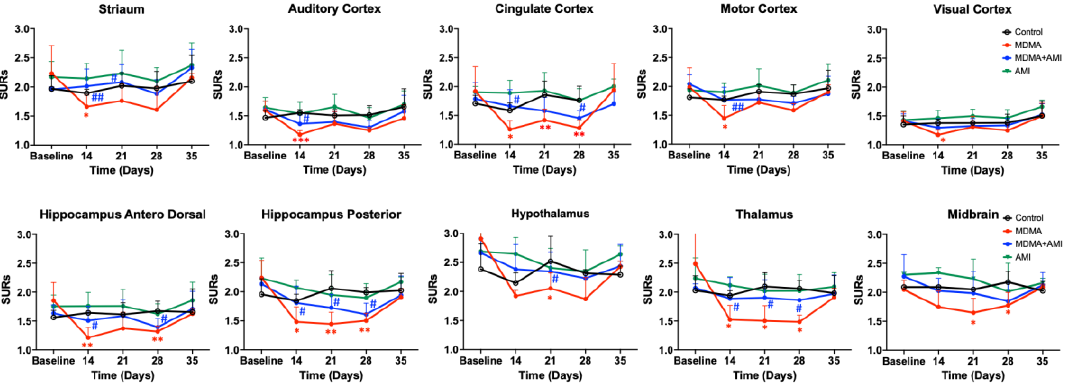
Figure 3. Specific uptake ratios (SURs) of 4-[ 18 F]-ADAM of baseline and on day 7, 14, 21, 28 and 35 from the beginning of the 4-day treatment in rat brain regions. Compared to the control (black lines), MDMA administration resulted in significant reduction the SURs of 4-[ 18 F]-ADAM from day 14 to day 28 and returned to the baseline on day 35 (red line, red * p < 0.05, ** p < 0.01, *** p < 0.005, Group B-MDMA vs. Group A-control). MDMA with AMI pretreatment showed remarkable increase of 4- [ 18 F]-ADAM binding as compared to the MDMA group (blue line, blue # p < 0.05, ## p < 0.01, Group C-MDMA+AMI vs. Group B- MDMA). AMI alone (green lines) showed a similar pattern of SURs to that in the control (black lines) throughout the study. Data are mean ± SD. Detailed statistical results between each group are summarized in Figure